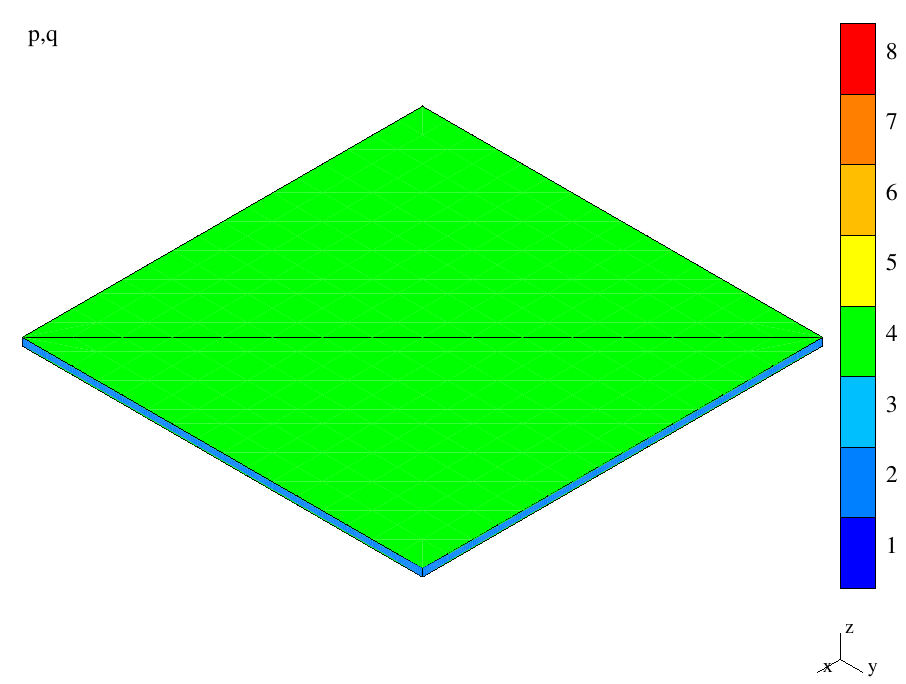
Figure 12. A quarter of a bending-dominated plate—mesh after optimized